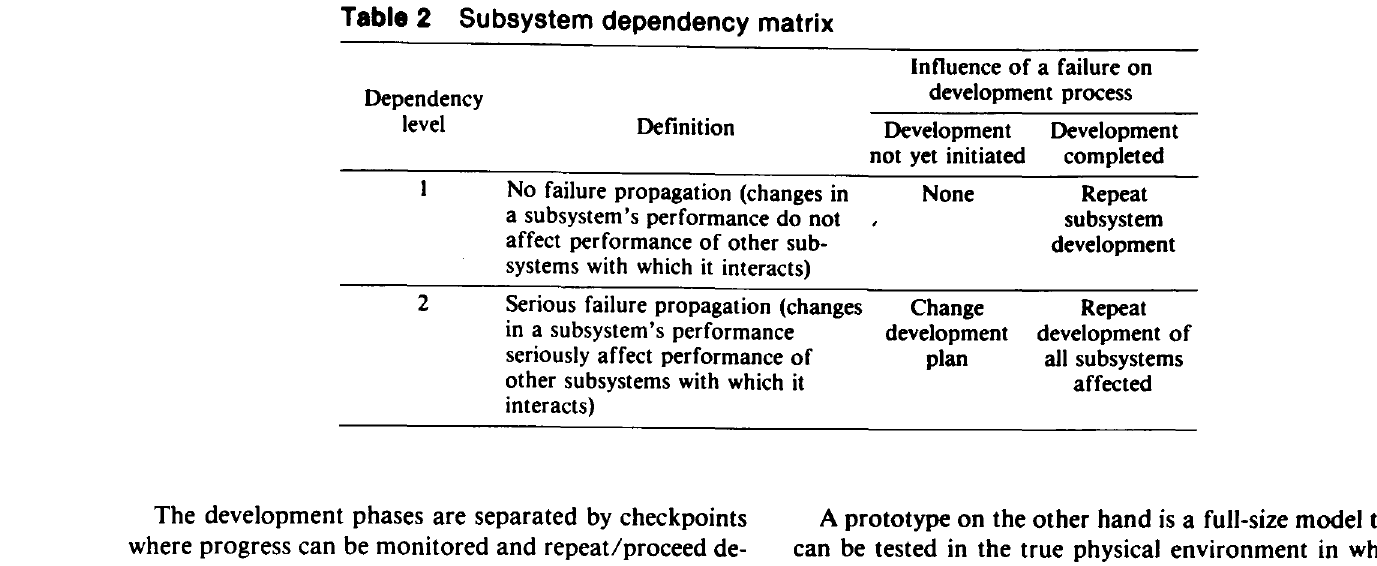
Development phases in technological